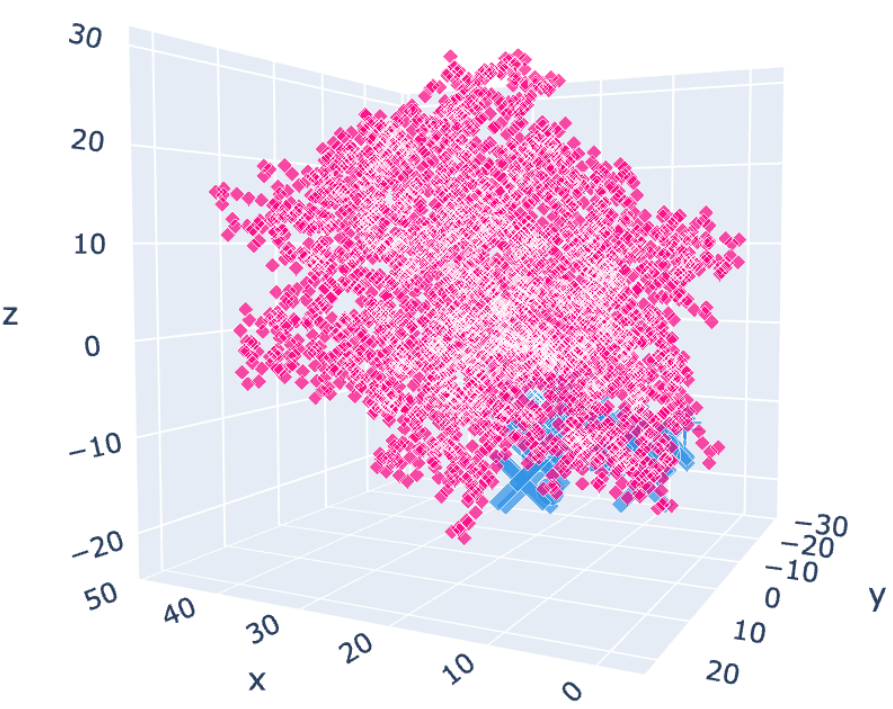
Figure 11. Chosen cluster location for the APRT variant 6hgs. Rose: centroids of the receptor residues. Blue: centroids of the docked molecules. Table 4. Affinity of the synthesized compounds for the APRT crystal variants. AutoDock Vina data for the most occupied cluster on the protein